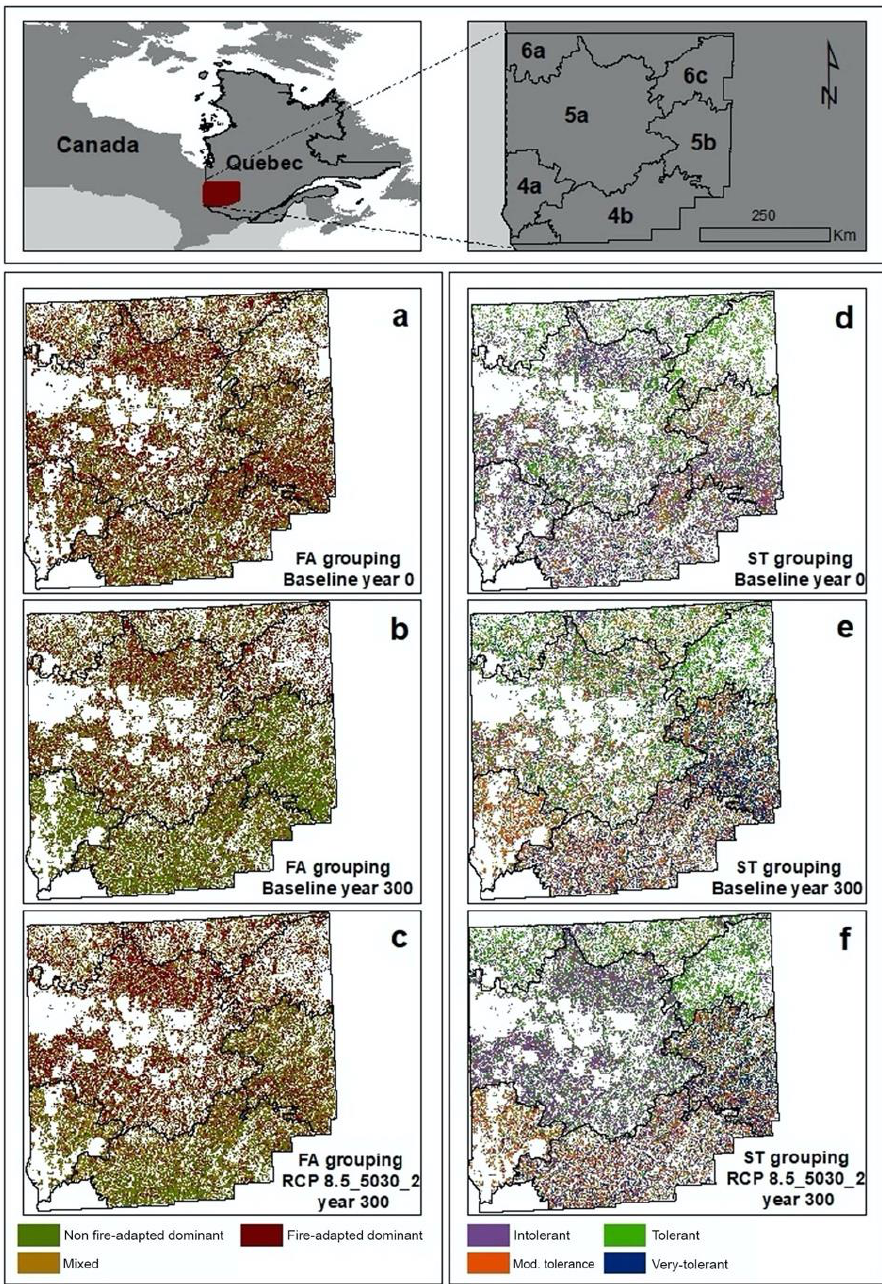
Figure 3. Simulations of fire adaptation (FA) and shade tolerant (ST) functional groups of trees in the Boreal Forest of Quebec under the Baseline and RCP 8.5 5032_2% scenarios at the beginning (year 0) and at the end of the simulation (year 300) for the study area. ( a ) Fire adaptation functional group in the Baseline scenario at the beginning of the simulation period, ( b ) fire adaptation functional group in the Baseline scenario at the end of the simulation period, ( c ) fire adaptation functional group in the RCP 8.5 5030_2% scenario at the end of the simulation period, ( d ) shade-tolerant functional group in the Baseline scenario at the beginning of the simulation period, ( e ) shade-tolerant functional group in the Baseline scenario at the end of the simulation period, ( f ) shade-tolerant functional group in the RCP 8.5 5030_2% scenario at the end of the simulation period. White areas on the map represent agricultural areas or water